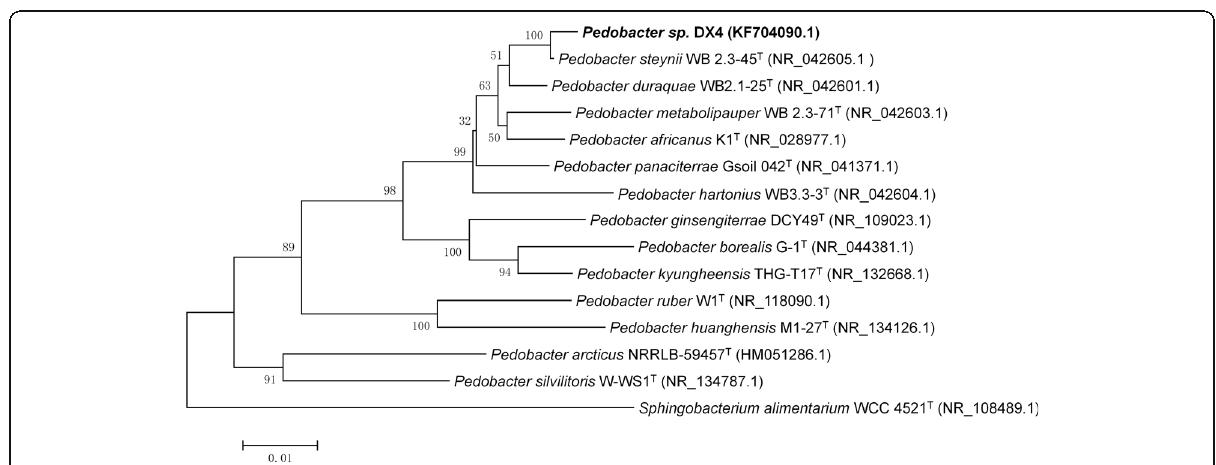
Fig. 5 The genome map of Pedobacter steynii strain DX4.Circle 1: Base pair numbers; Circle 2 and Circle 3:Forward and reverse coding domain sequences, the color coding of the CDS represent different Clusters of Orthologous Groups categories; Circle 4: rRNA and tRNA; Circle 5: % GC plot; Circle 6:GC skew [(GC)/(G +